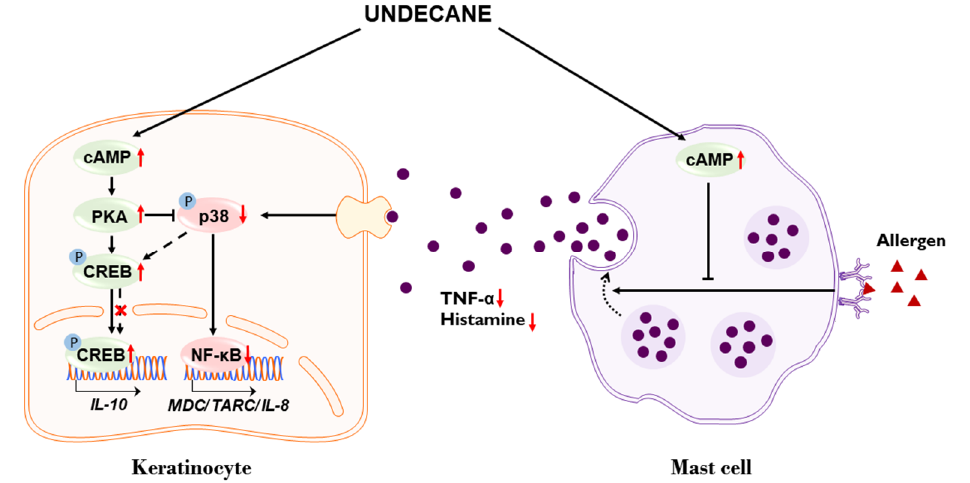
Figure 5. Proposed mechanism by which undecane suppresses inflammatory responses in keratinocytes and mast cells.